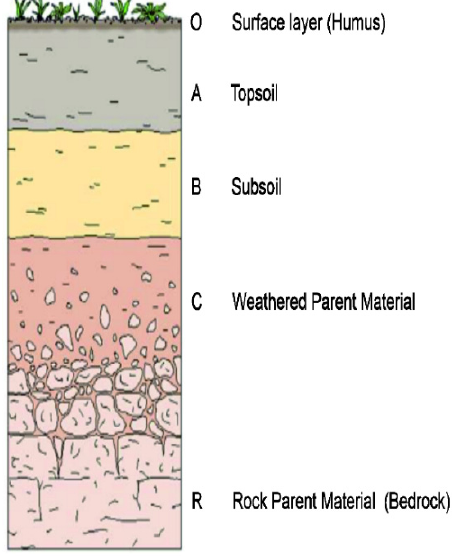
Figure 6. Soil horizons (layers), taken from [32].